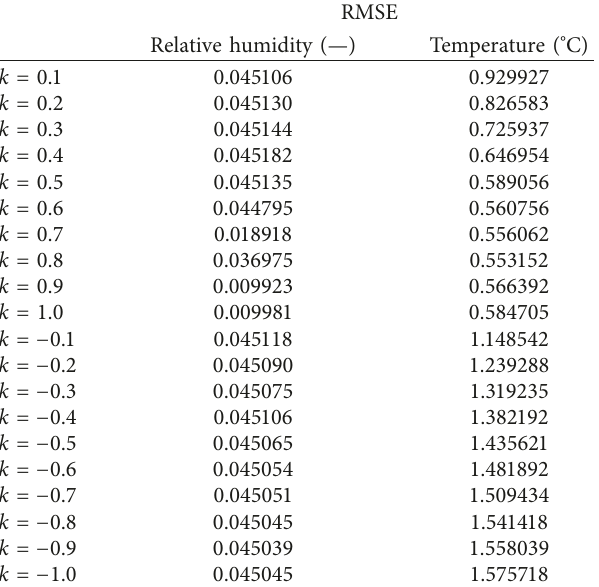
Figure 5: Experimental verification of the model for coupled heat and moisture transport Table 2: Evaluation of the influence of the k parameter on the accuracy of results.